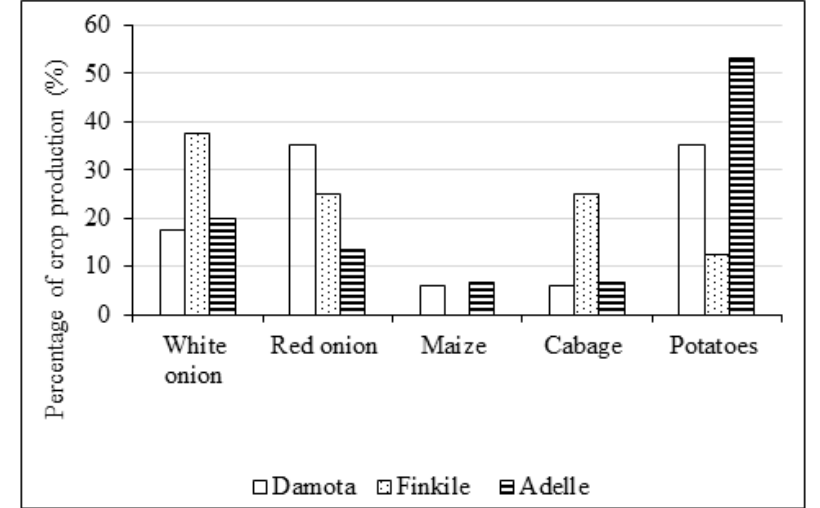
Figure 9. Types of crops grown in the three selected kebeles of the Haramaya District (Source: Elaborated by the Authors).